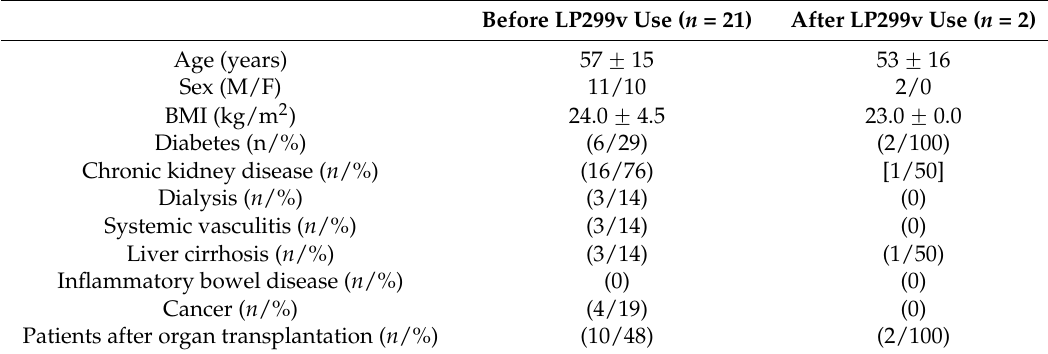
Table 1. Characteristics of patients diagnosed with Clostridium difficile infections (CDI) ( n = 23).